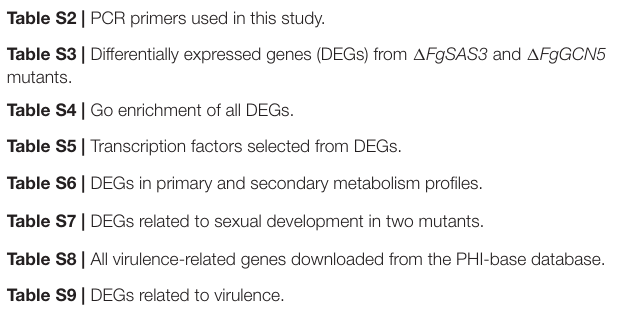
Figure S2 | Venn diagram of DEGs in comparisons of 1 FgSAS3 and 1 FgGCN5 . Table S1 | Comparisons of the putative HATs in F. graminearum with those in other six species. Table S2 | PCR primers used in this study. Table S3 | Differentially expressed genes (DEGs) from 1 FgSAS3 and 1 FgGCN5 mutants. Table S4 | Go enrichment of all DEGs. Table S5 | Transcription factors selected from DEGs. Table S6 | DEGs in primary and secondary metabolism profiles. Table S7 | DEGs related to sexual development in two mutants. Table S8 | All virulence-related genes downloaded from the PHI-base database. Table S9 | DEGs related to